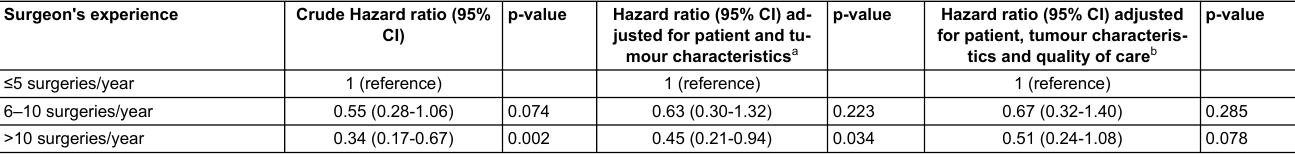
Table 4: Effect of the surgeon's experience on breast cancer-specific mortality at 5 years (Geneva Cancer Registry, 2000–2009). Surgeon's